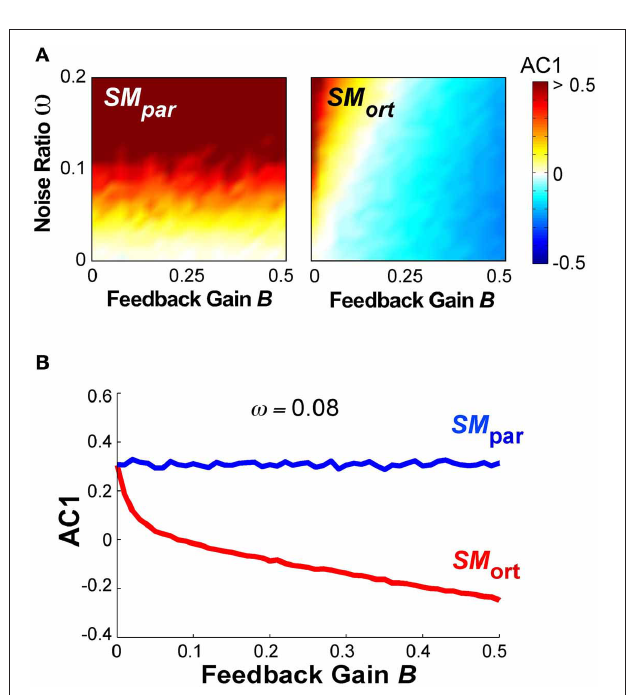
FIGURE 10 | (A) Simulation results for lag-1 autocorrelation AC1 at θ par and θ ort as a function of feedback gain B and relative noise ratio ω . Color bar (right) represents the autocorrelation values. (B) Simulation result for lag-1 autocorrelation (AC1) at θ par and θ ort as a function of B with ω = 0 . 08 that shows a similar pattern as the experimental results as a function of